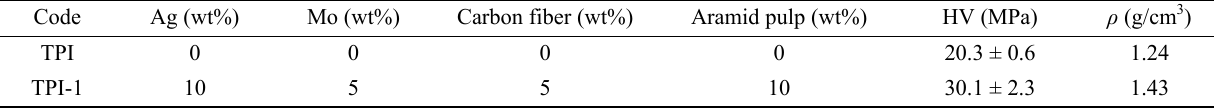
Table 1 Chemical compositions of TPI